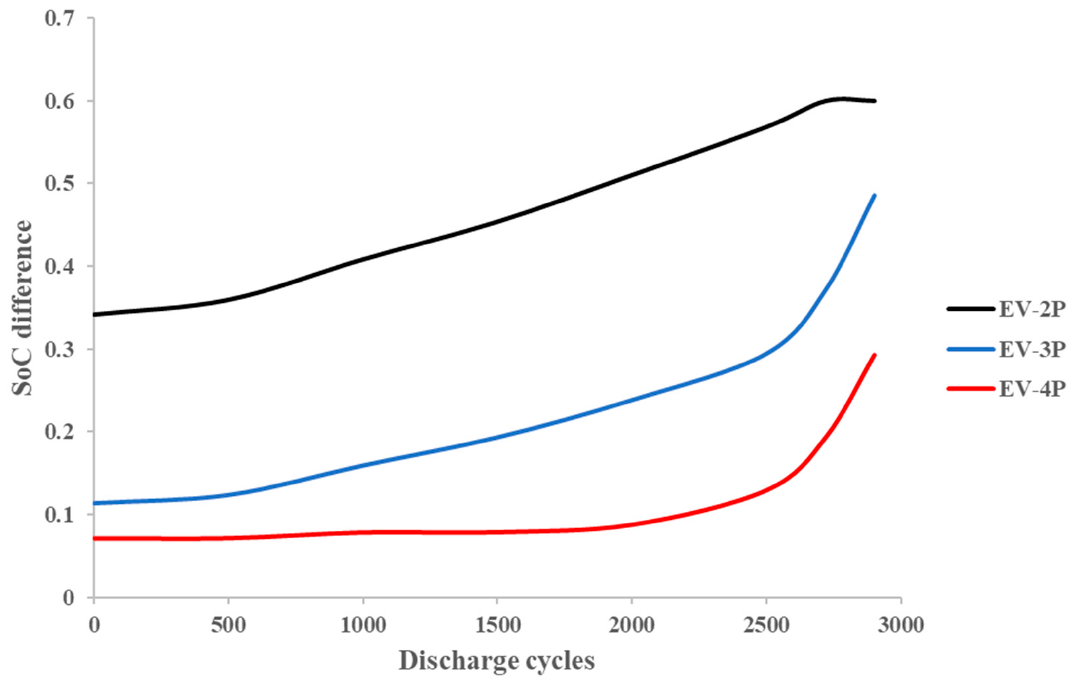
Figure 16. The SoC difference in different second life batteries discharge cycles for various scenarios.